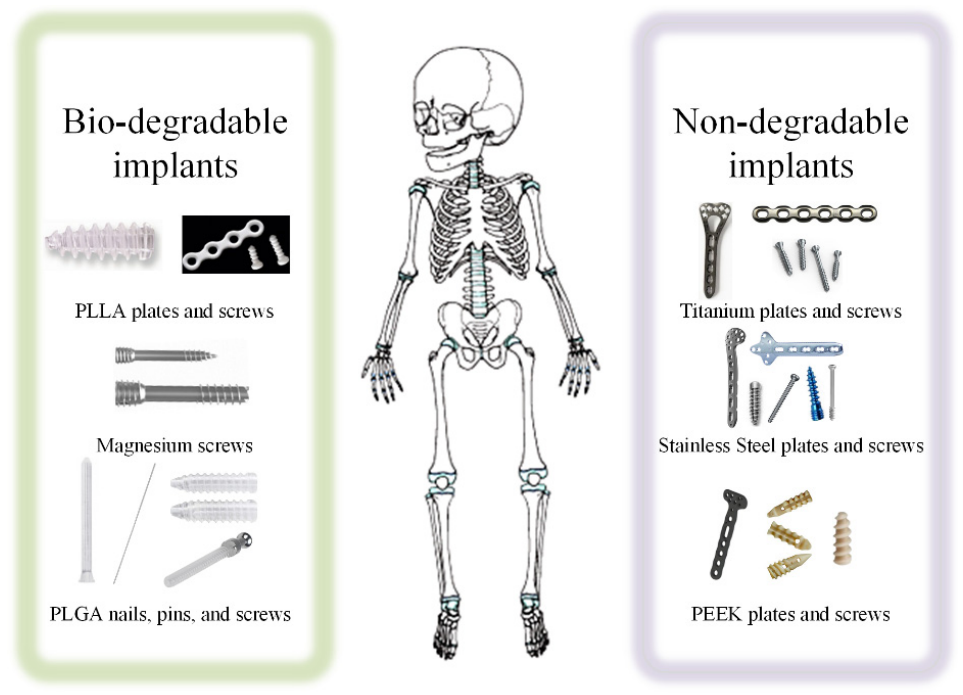
Figure 1. Biocompatible implants used in pediatric fracture treatment.